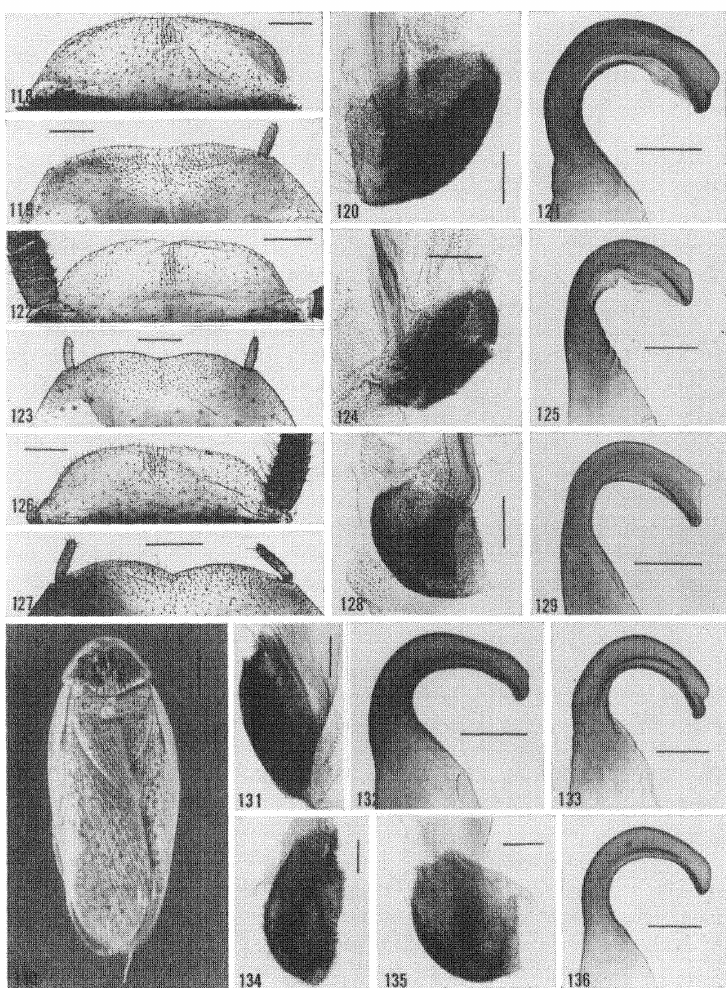
Figures 118-136. Calolamra gracilis. 118-121. 8 (25 SAM), Mt. Bryan E., S. A. 118-119. Supra-anal plate and hypandrium. 120-121. Genitalia. 122-125. 8 (26 SAM), Norwood, S. A. 122-123. Supra-anal plate and hy- pandrium. 124-125. Genitalia. 126-129. 8 (27 SAM), Yardea, S. A. 126- 127. Supra-anal plate and hypandrium. 128-129. Genitalia. 130. 8 (261 L), Cabramatta, N.S.W. 131-132. Genitalia of specimen shown in figure 130. 133-134. 8 (260 L), same locality as 261 L. Genitalia. 135-136. 8 (264 L), same locality as 261 L. Genitalia. Scale: Figs. 118-119, 122-123, 126-127 0.5 mm Figs.120-121, 124-125, 128-129, 131-136 0.2 mm; Fig.